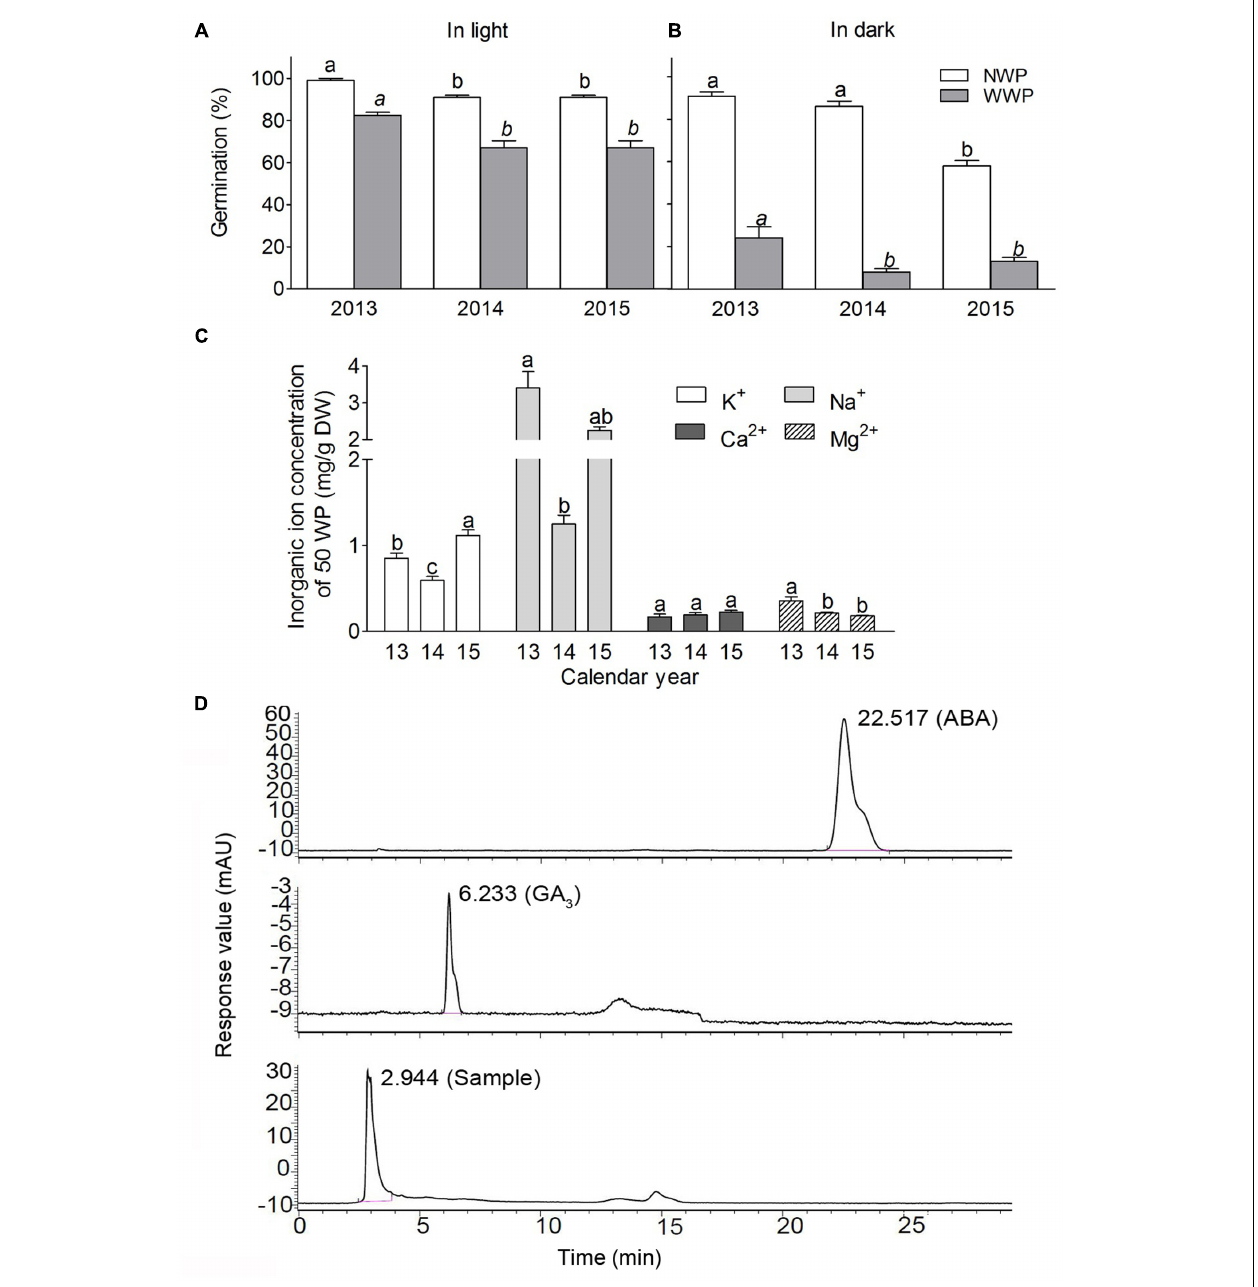
FIGURE 8 | Effect of winged perianth (WP) on germination and analysis of ions and phytohormone of WP of heteromorphic seeds of S. ferganica . (A) Germination in light. (B) Germination in dark. 2013, 2014, 2015: Calendar year of seed collection. NWP, non-winged perianth; WWP, with winged perianth. (C) Ion concentrations of winged perianth. Ions were extracted from 500 pieces of winged perianth with 100 mL deionized distilled water. CK: deionized H 2 O; 13, 14, 15: 2013, 2014, 2015 calendar year. (D) Chromatographic curve of two phytohormones. Upper panel: ABA standard product, ABA peak appeared at 22.517 min; middle panel: GA 3 standard product, peak at 6.233 min; lower panel: sample extracted from WP, peak at 2.944 min. Bars with different lowercase letters indicate significant differences ( P < 0.05) according to the Tukey’s test. Values are means ± SE of four